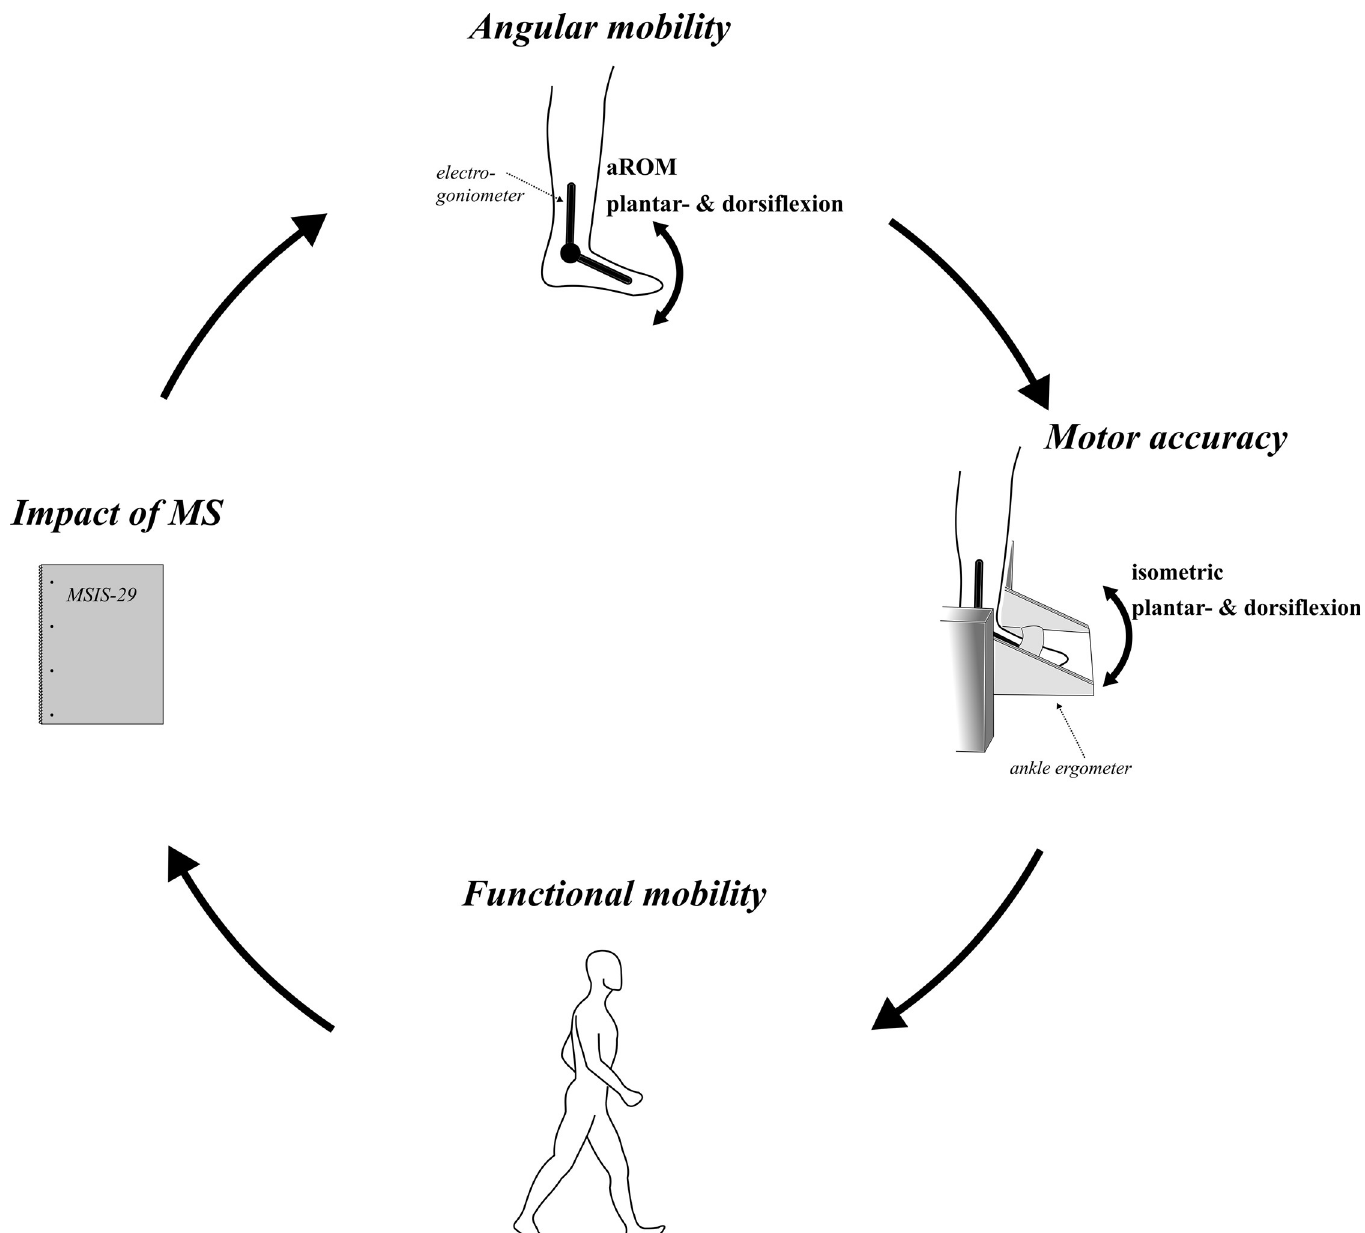
Fig 2. Overview of the applied assessments. The assessments included (1) angular mobility by means of aROM measures in the ankle joint using electro-goniometry and (2) motor accuracy by means of plantarflexion and dorsal extension with biofeedback. Additionally, (3) functional mobility was assessed by means of the Timed “Up & Go” test (TUG) and (4) impact of MS with the Multiple Sclerosis Impact Scale (MSIS-29).